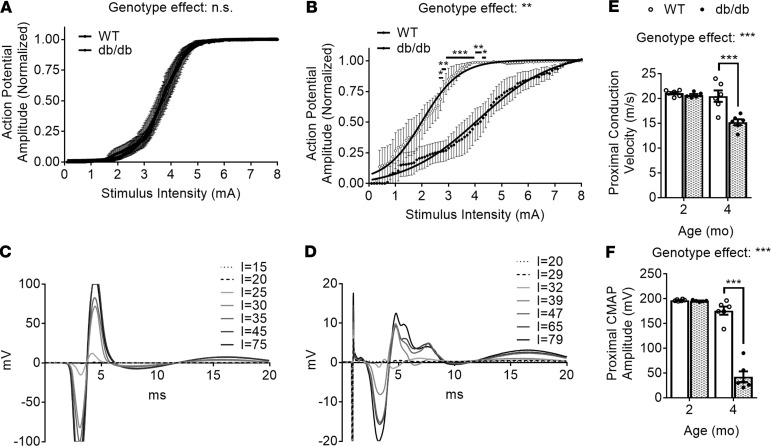
Impaired sciatic nerve function in obese diabetic mice.Relationship between the evoked action potential response and the stimulus intensity (input/output curves) for 2- and 4-month-old (A and B, respectively) WT (open circles/bars) and db/db (filled circles/bars) mice. Representative waveforms of sciatic nerve supramaximal responses in 4-month-old WT (C) and db/db (D) mice. Proximal conduction velocities (E) and compound motor action potential (CMAP) amplitudes (F) are displayed as dot blots with bars; each dot represents 1 animal; data are displayed as the mean ± SEM of n = 5–6 mice per genotype (left and/or right sciatic nerves were recorded 1–2 times for each mouse). Genotype effects for input/output curves were compared using 2-way ANOVA and Holm-Šidák multiple-comparisons tests on GraphPad Prism 7. *P < 0.05, **P < 0.01 ***P < 0.001.